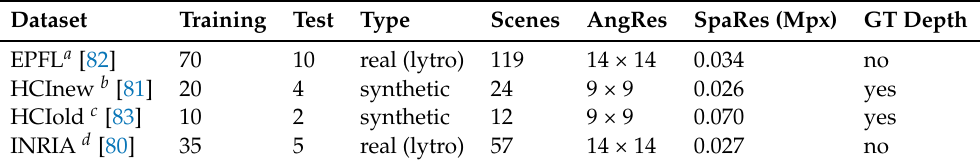
Table 1. Public datasets used in this work and its characteristics.